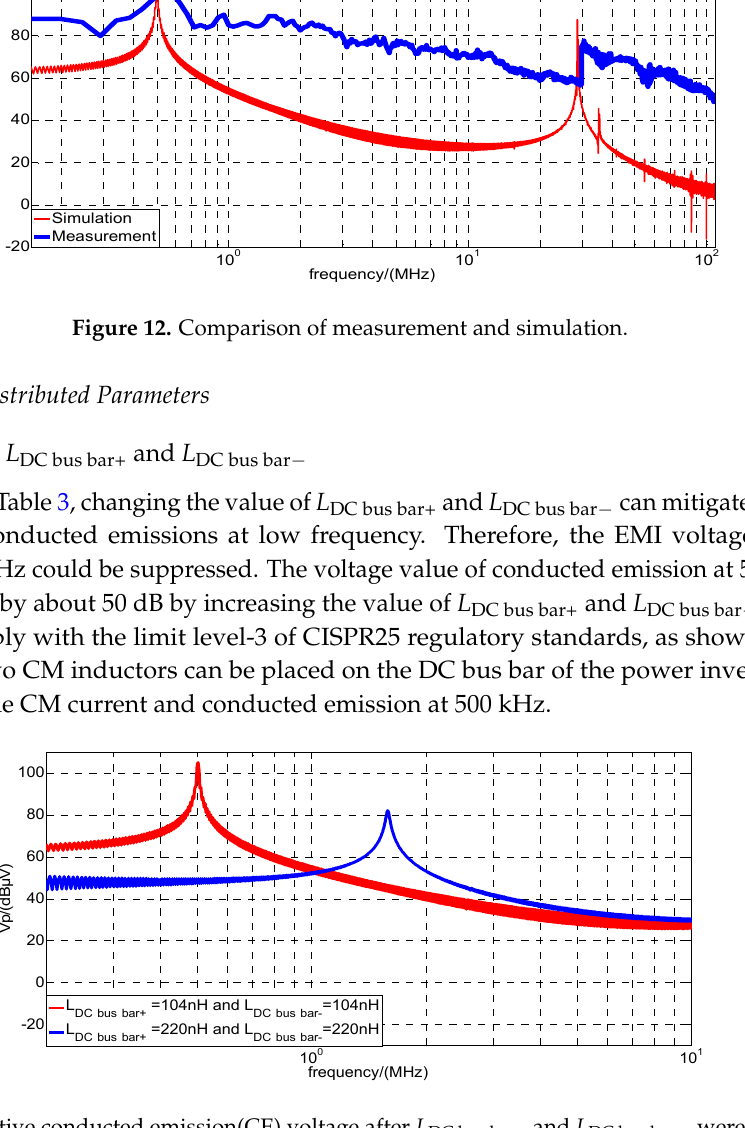
Figure 11. CM circuit model of single-arm bridge of power inverter.